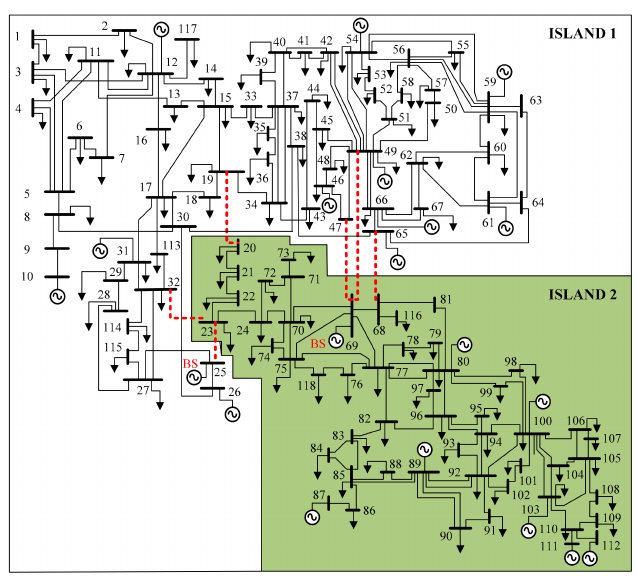
Figure 8. Restoration strategy for IEEE 118 bus.